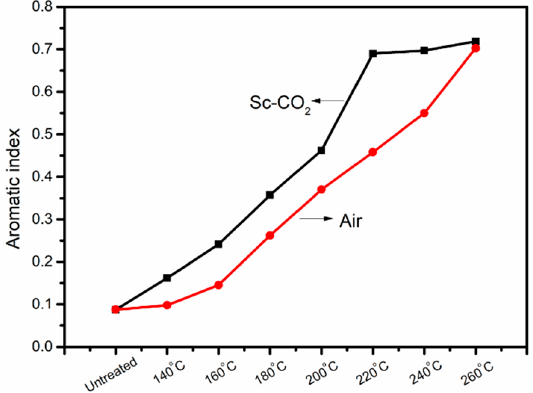
Figure 6. Aromatic Index of PAN fibers treated at different temperatures in air and Sc-CO 2 .